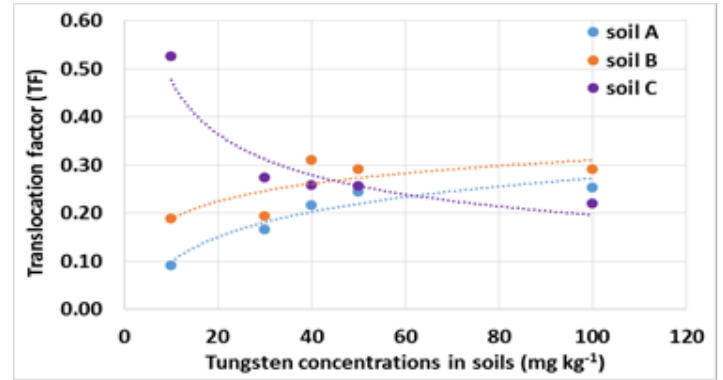
Figure 1. Trend of translocation factor at increasing tungsten concentrations in soils.